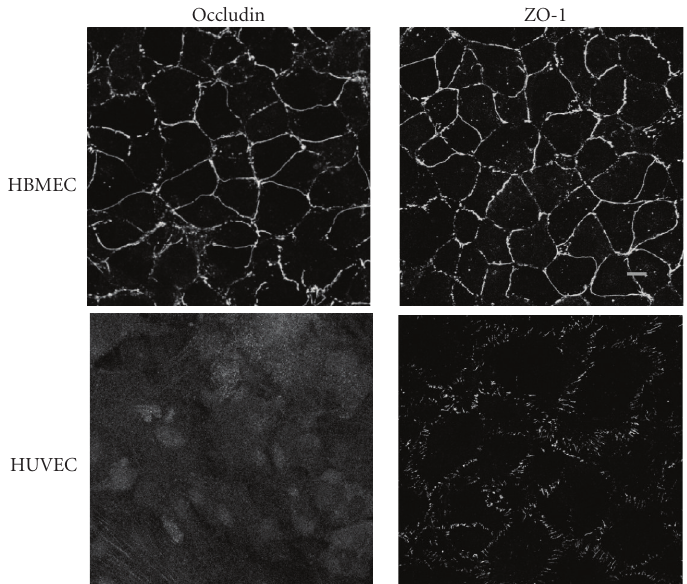
Figure 1: Confluent THBMEC cultures possess intercellular TJs while HUVECs do not. Three di ff erent passages of THBMECs and HUVECs were cultured to confluence. Endothelial cells were stained with rabbit anti-human ZO-1 and occludin antibodies followed by FITC conju- gated goat anti-rabbit IgG. Digital pictures were taken following visualization with a Leica Aristoplan laser scanning confocal microscope. THBMEC cultures exhibited continuous ZO-1 and occludin expression at sites of intercellular contact. In contrast, HUVEC cultures showed punctate ZO-1 staining and no occludin immunoreactivity. Scale bar 10 μ m.